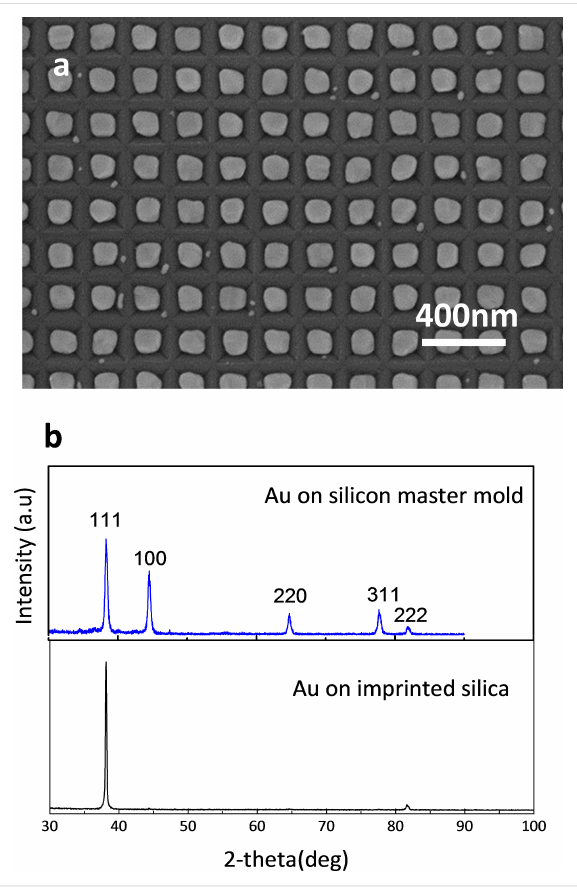
Figure 8: (a) SEM image of Au nanoparticles dewetted on the silicon master mold by annealing at 500 °C and (b) a comparison of XRD spectra for Au particle arrays formed on the imprinted sol–gel silica in Figure 6h and silicon master mold in Figure 8a.